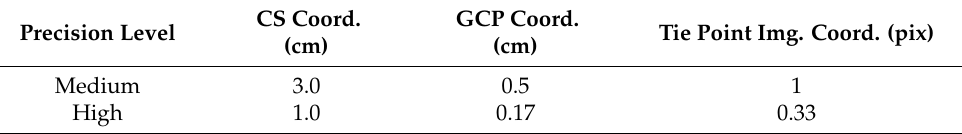
Table 4. Measurement precisions levels considered in the simulations.